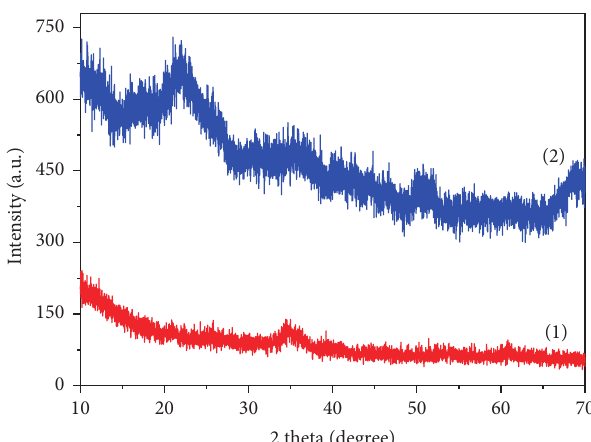
Figure 4: XRD patterns of (1) ferric oxide and (2) ferric oxide-